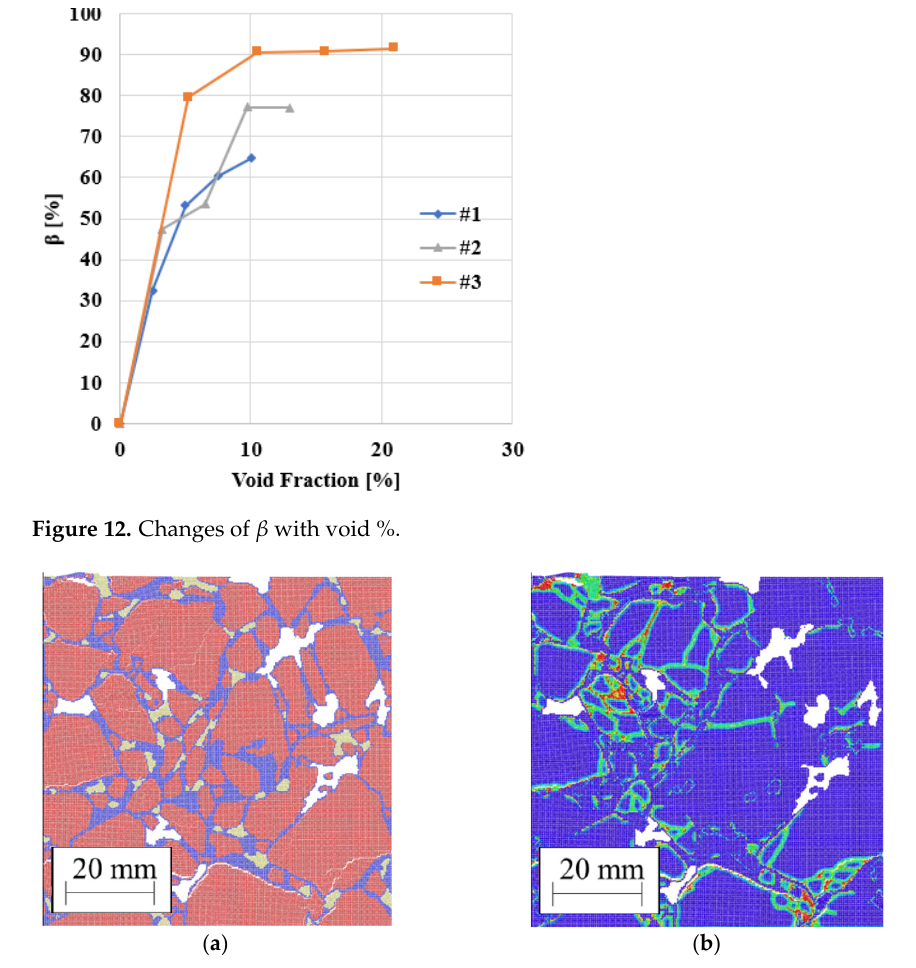
Figure 13. Cracking propagation due to ice expansion: ( a ) geometry; ( b ) damage.